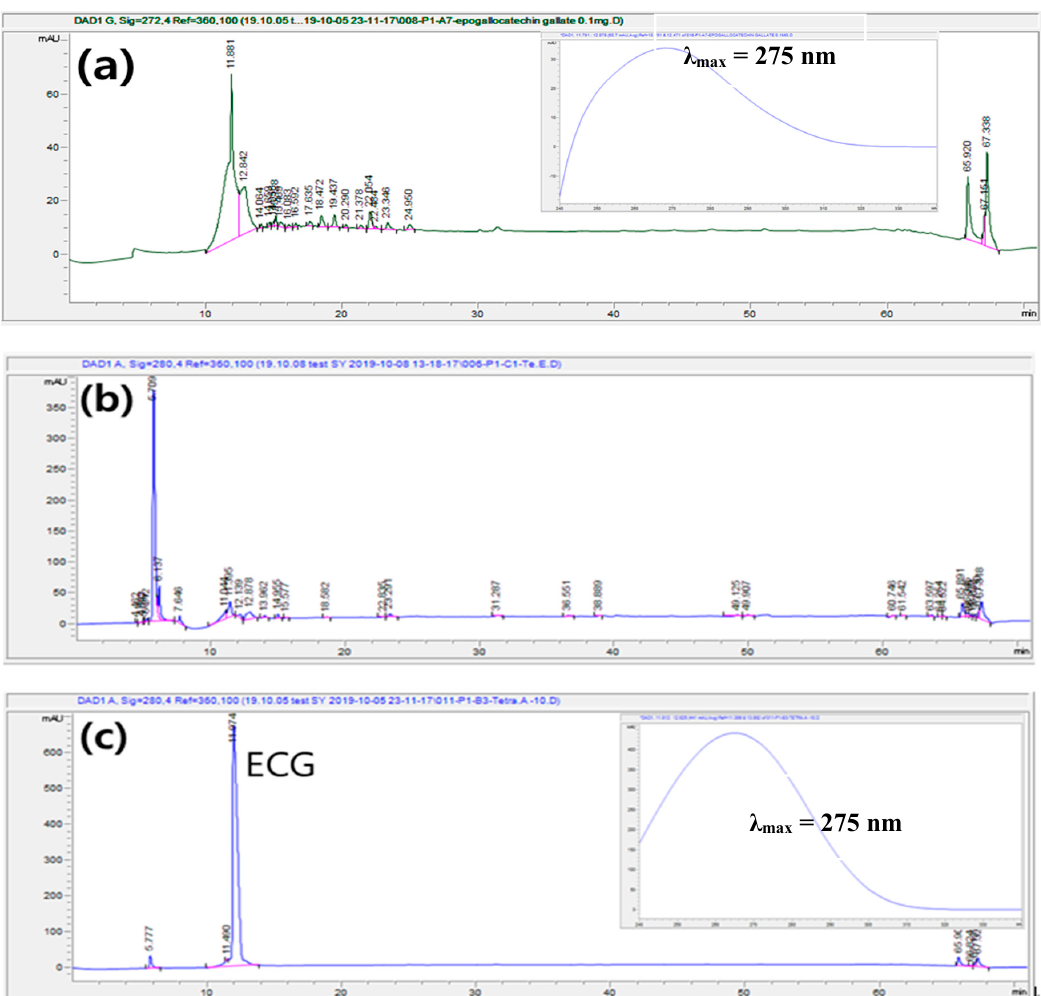
Figure 7. HPLC (high-performance liquid chromatography) chromatograms of epigallocatechin gallate (EGCG) standard ( a ), phenolic compounds from lipid extracted microalgae (LEM) extracted by water, ( b ) and by ethanol under optimized UAE condition ( c ). ( a ) Chromatogram of EGCG standard solution in water (0.1 mg/mL), ( b ) chromatogram of EGCG from LEM extracted by UAE using water (74.4 °C, 59.6 min, water), ( c ) chromatogram of EGCG from LEM extracted by UAE using ethanol (74.4 °C, 59.6 min, 55.4% ethanol).